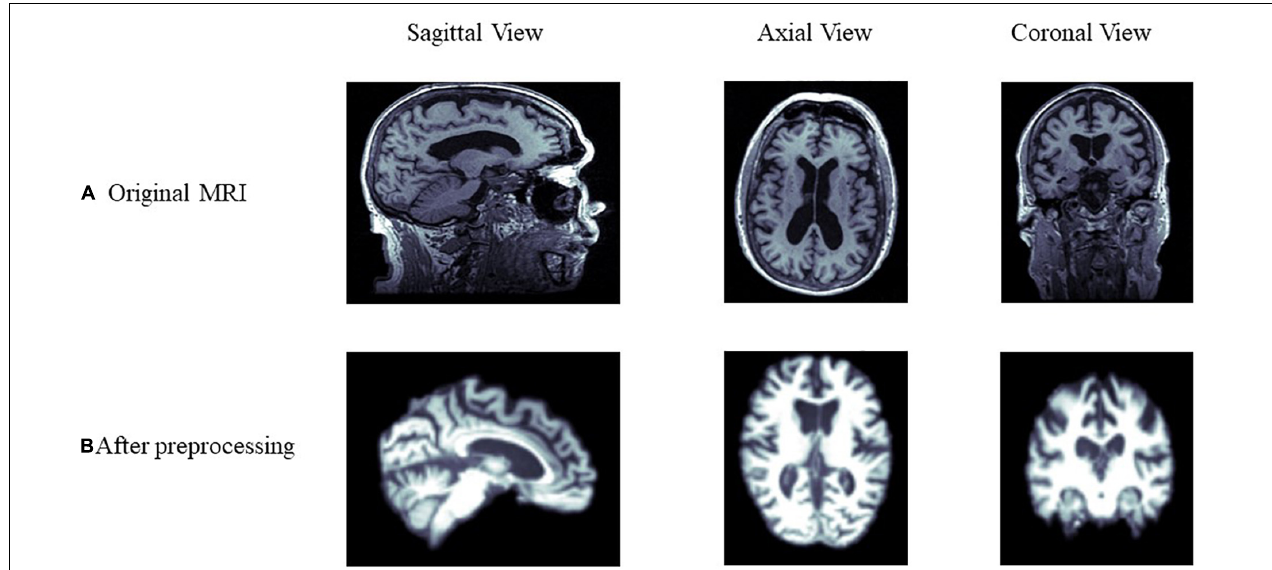
FIGURE 2 | Comparison of MRI data before and after preprocessing. (A,B) Show the differences before and after preprocessing from the sagittal, axial, and coronal view of the brain, respectively.